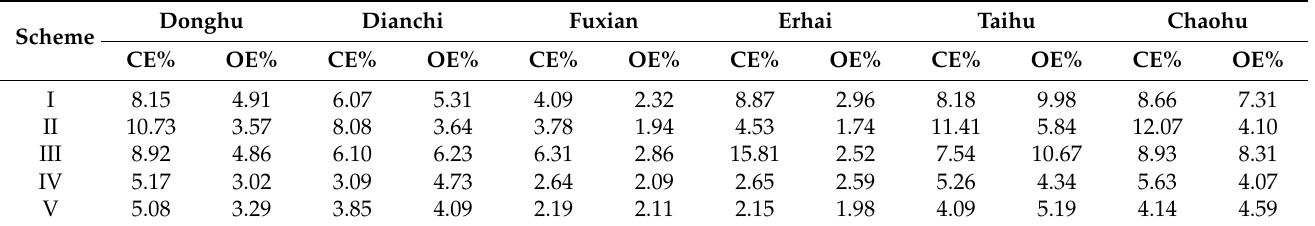
Table 5. Error calculations across the six lakes.